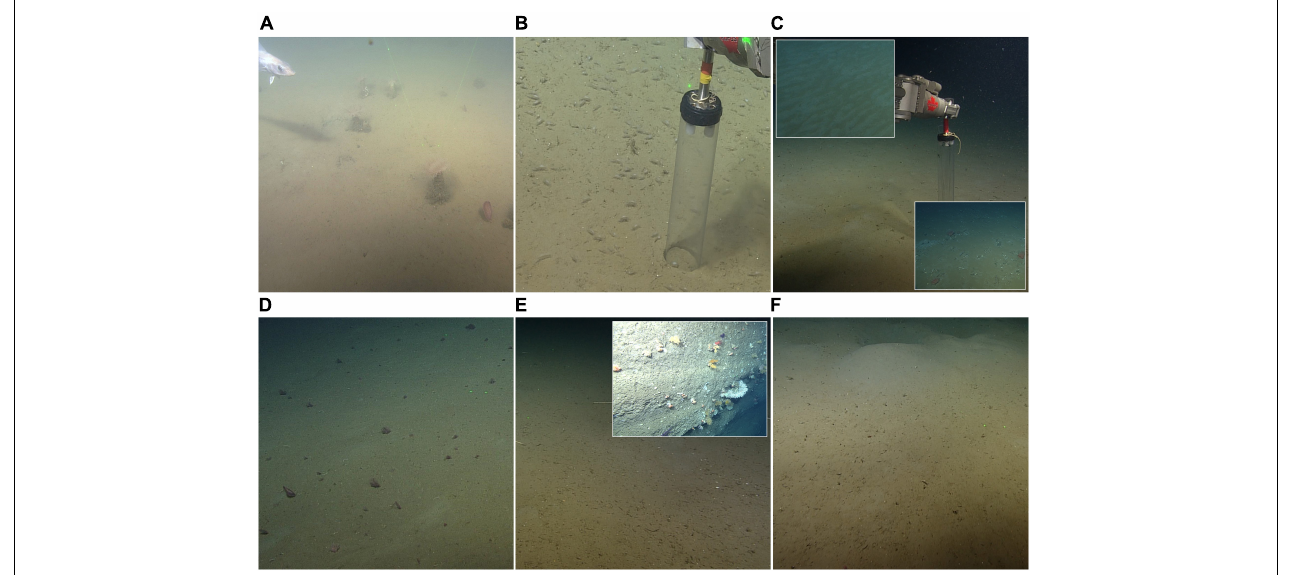
FIGURE 8 | Submarine images of some of the stations sampled in our study (photo credits CSSF ROPOS). (A) Megafauna-rich seafloor at the sediment sampling site in Western Jordan Basin (continental shelf); (B) ROPOS arm collecting a push core at the continental slope outside Georges Canyon where some sea pigs are visible on the seafloor; (C) ROPOS arm collecting a sediment push core, ripples (top left) and signs of material deposition in Georges Canyon (bottom right); (D) Pennatula sea pen field at sediment sampling site in Fiddler’s Cove (continental slope); (E) Mostly bare sediments at the sediment sampling site in Nygren-Heezen Inter-canyon and inter-canyon wall colonized by mega-epifauna in Munson-Nygren Inter-canyon (top right); and (F) Mostly bare sediments in Corsair Canyon at the sediment sampling site with signs of bioturbation.